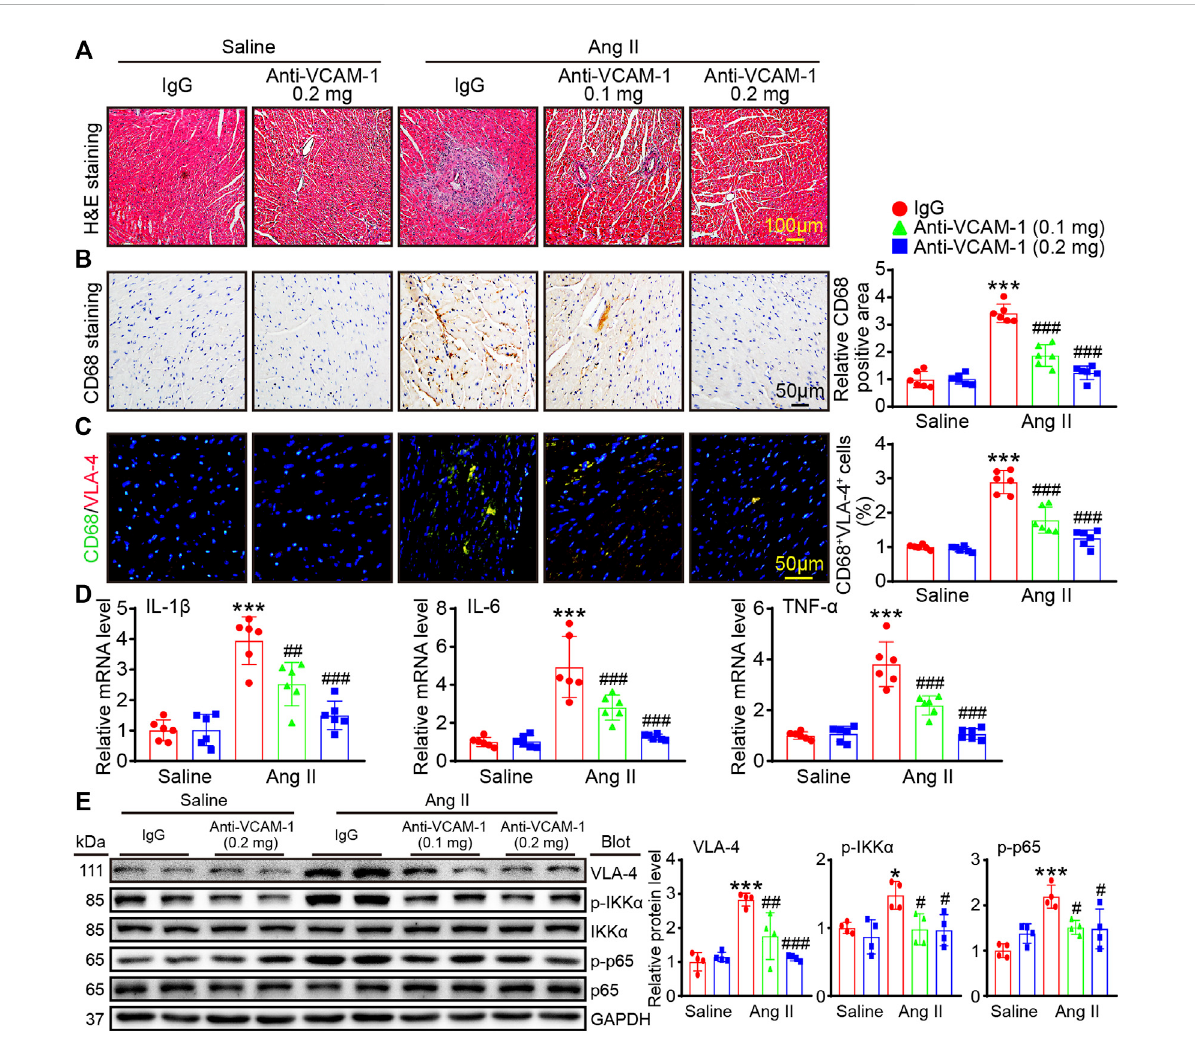
FIGURE 4 Blocking VCAM-1 inhibits Ang II-induced VLA-4 + macrophage in fi ltration and the expression of proin fl ammatory cytokines. (A) H&E staining of heartsections.Scalebar:100 μ m (B) Immunohistochemicalstainingofheartsectionswithananti-CD68antibody(left).Scalebar:50 μ m.Analysisof CD68-positivemacrophages(right, n =6) (C) Immuno fl uorescencestainingofheartsectionswithananti-CD68andanti-VLA-4antibody(left).Scale bar:50 μ m.AnalysisofCD68andVLA-4-positiveareas(right, n =6) (D) qPCRanalysis ofIL-1 β ,IL-6andTNF- α expressionintheheart( n =6) (E) Immunoblot analysis ofVLA-4, p-IKK α andp-p65 (left)andanalysisofthelevels oftheseproteins(right, n =4).Thedata areexpressed astheM±SD, and n represents the number of animals. * p < 0.05 and *** p < 0.001 vs saline + IgG group. # p < 0.05 and ### p < 0.001 vs Ang II + IgG